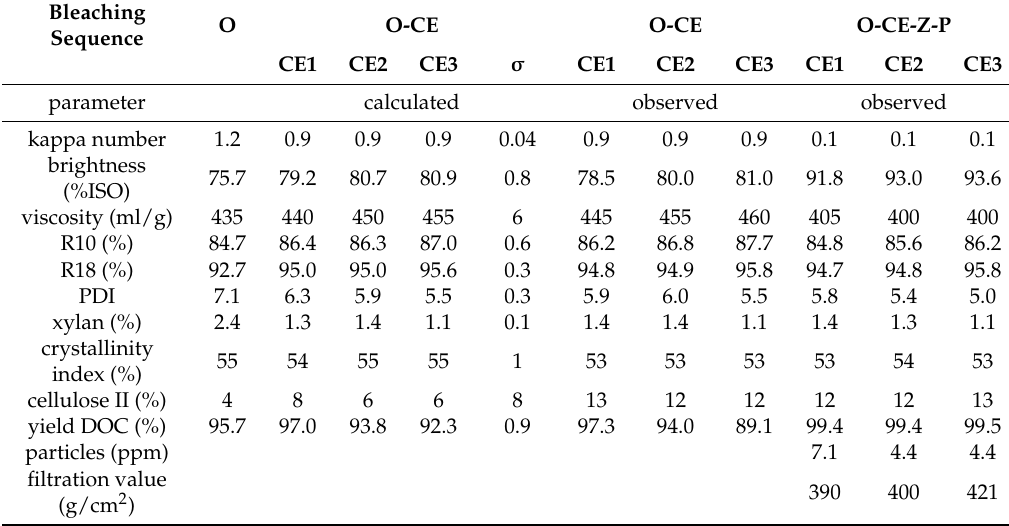
Table 2. Pulp properties of oxygen delignified pulp, pulp after alkaline extraction (predicted and actual), and further Z-P-bleached dissolving pulp.